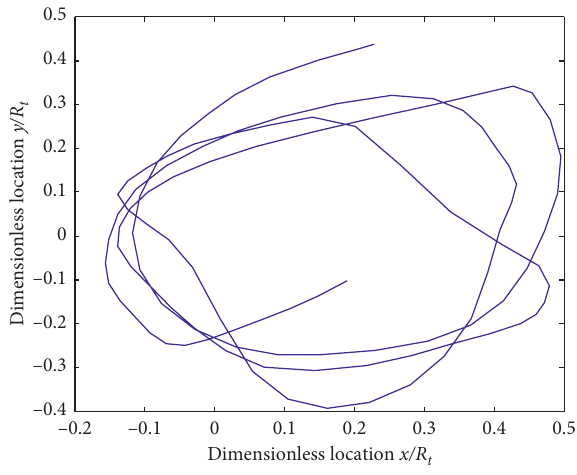
Figure 18: Track of tail center of SV.